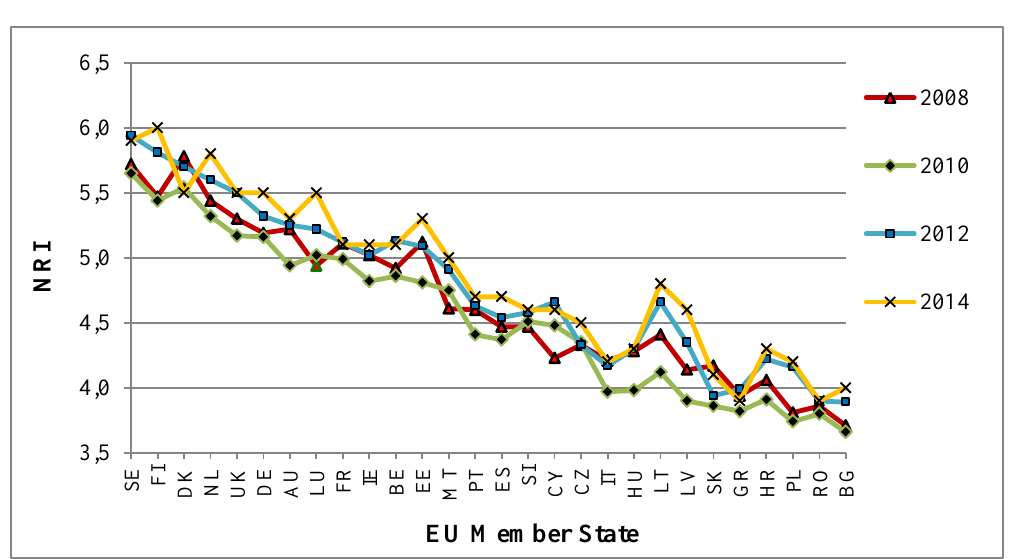
Figure 3: The progress of the NRI between the years